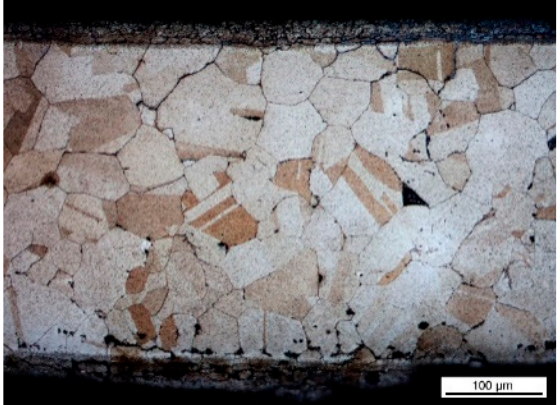
Figure 5. The ancient silver sample (of the silver bowl excavated in Yiwu City) was etched by diluted aqua regia (6 mL HCl + 2 mL HNO 3 and diluted to 12 mL); etching duration: 15 s; impurity removal: 1 mol/L sodium thiosulfate solution for 60 s.